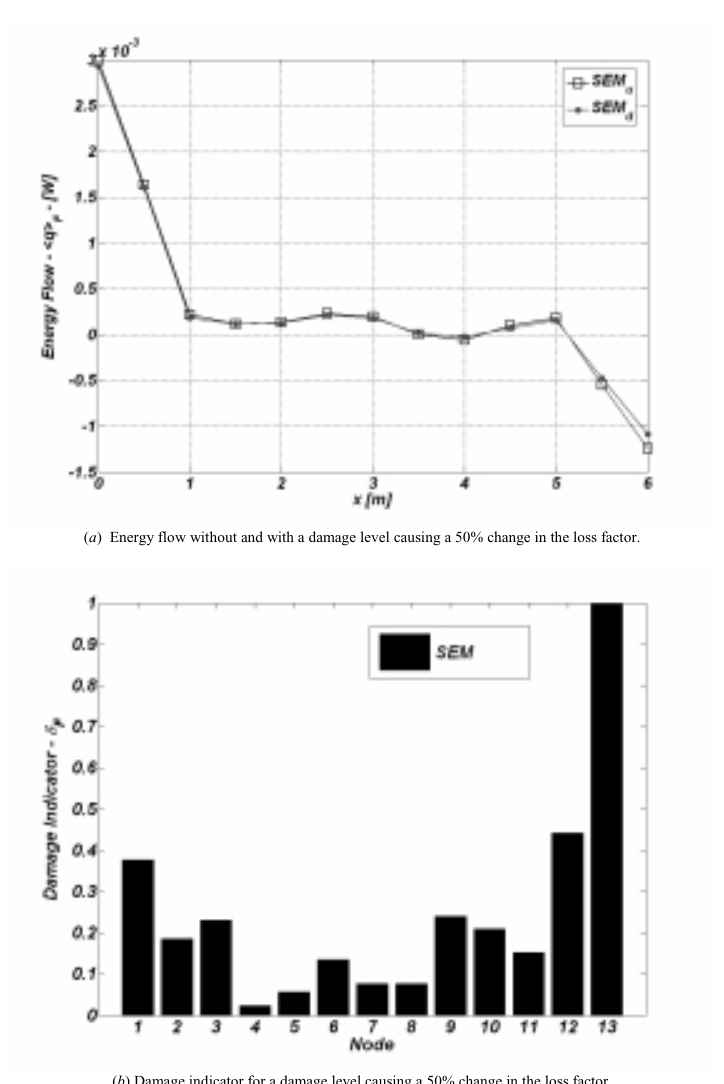
Fig. 4. Flexural energy flow and damage indicator by